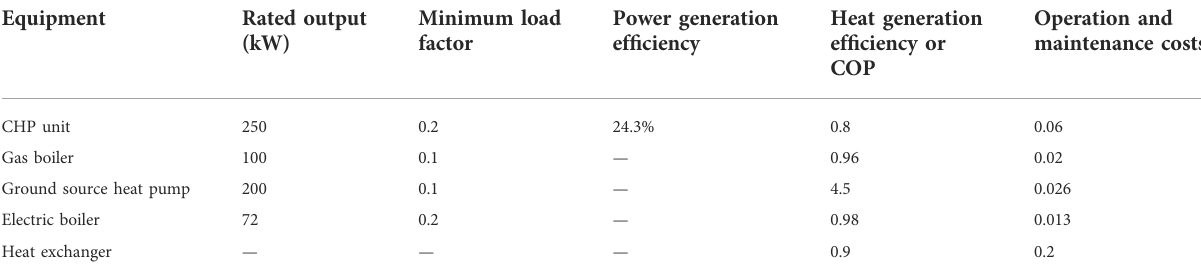
TABLE 3 System equipment